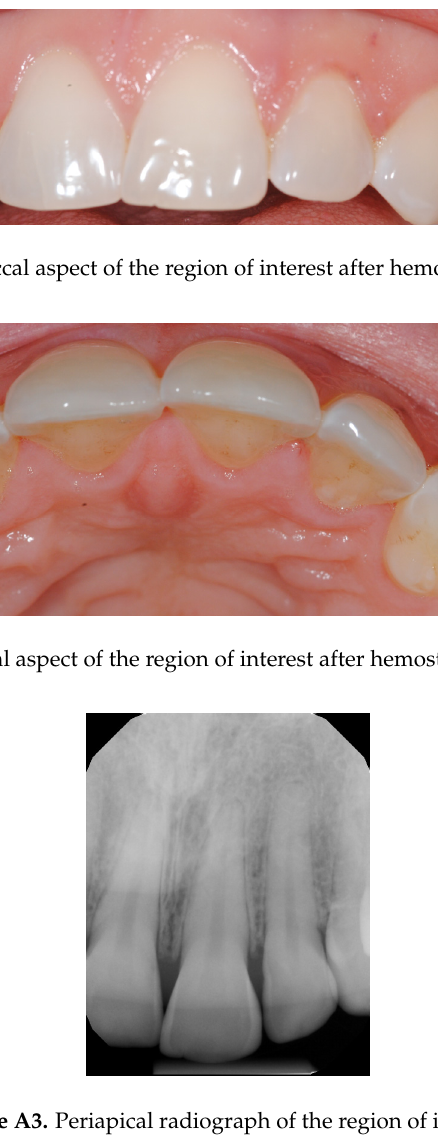
Figure A3. Periapical radiograph of the region of interest.